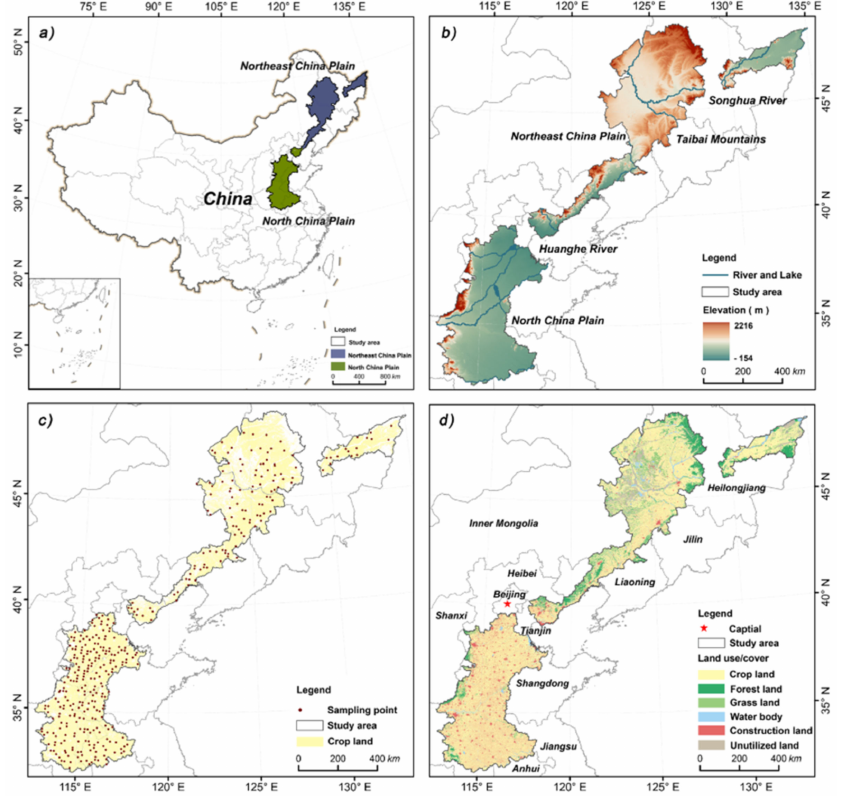
Figure 1. ( a ) Location of the study area in Northeast and North China Plain; ( b ) Topography of the study area; ( c ) Sample locations of the study area; ( d ) Land-use types of the study